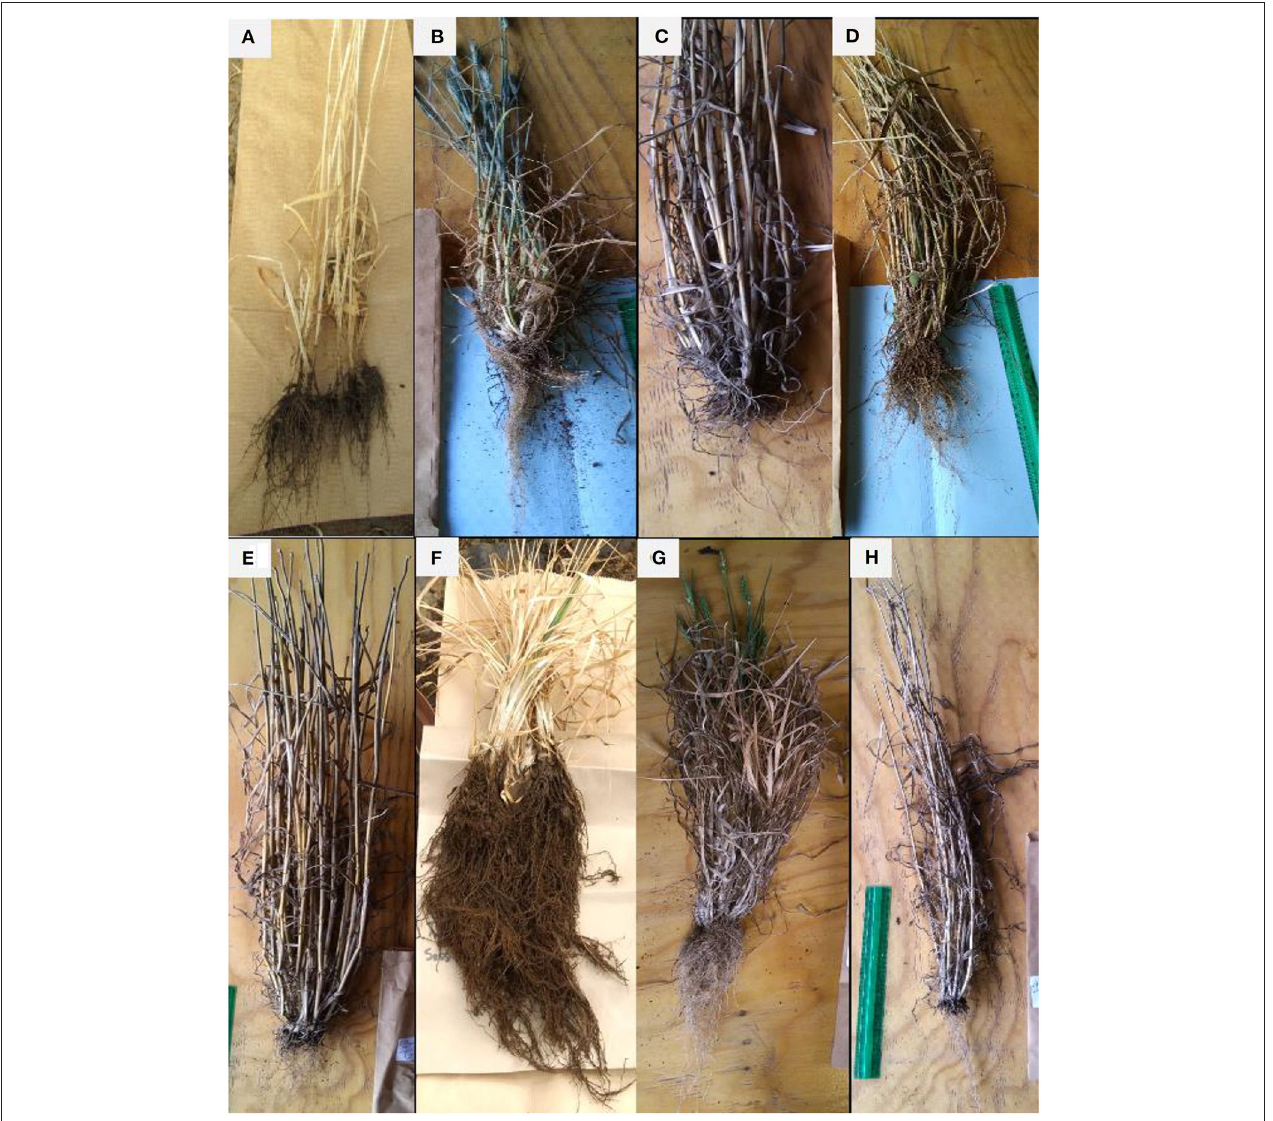
FIGURE 9 | Variation in biomass partitioning between roots and shoots among M 3 wheat populations. (A,B) (Population 1), (C,D) (Population 2), (E–G) (Population 3), and (H) (Control).